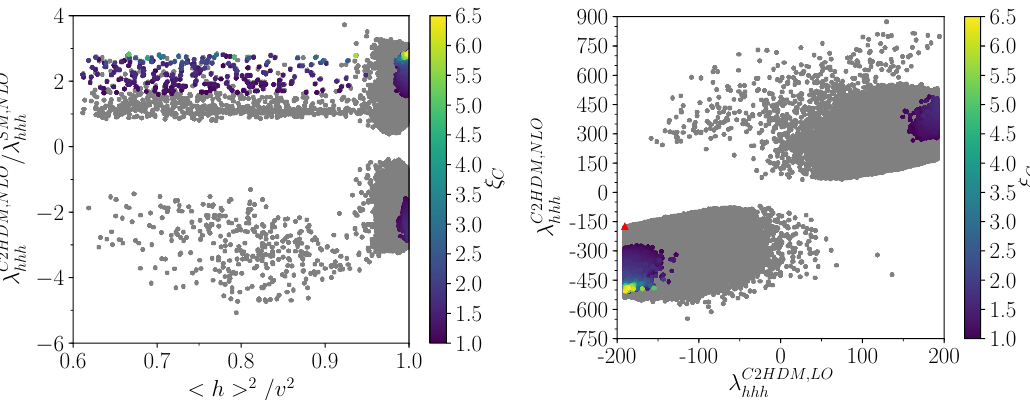
Figure 17 . Type II, H 1 = h : left: the C2HDM trilinear Higgs self-coupling between three SM-like Higgs bosons h normalized to the SM value, at NLO, as function of the fraction of the VEV squared carried by h ; right: the NLO coupling versus the LO value. Grey: all points passing the constraints; colour: points with additionally (cid:24) c > 1. The red triangle marks the SM